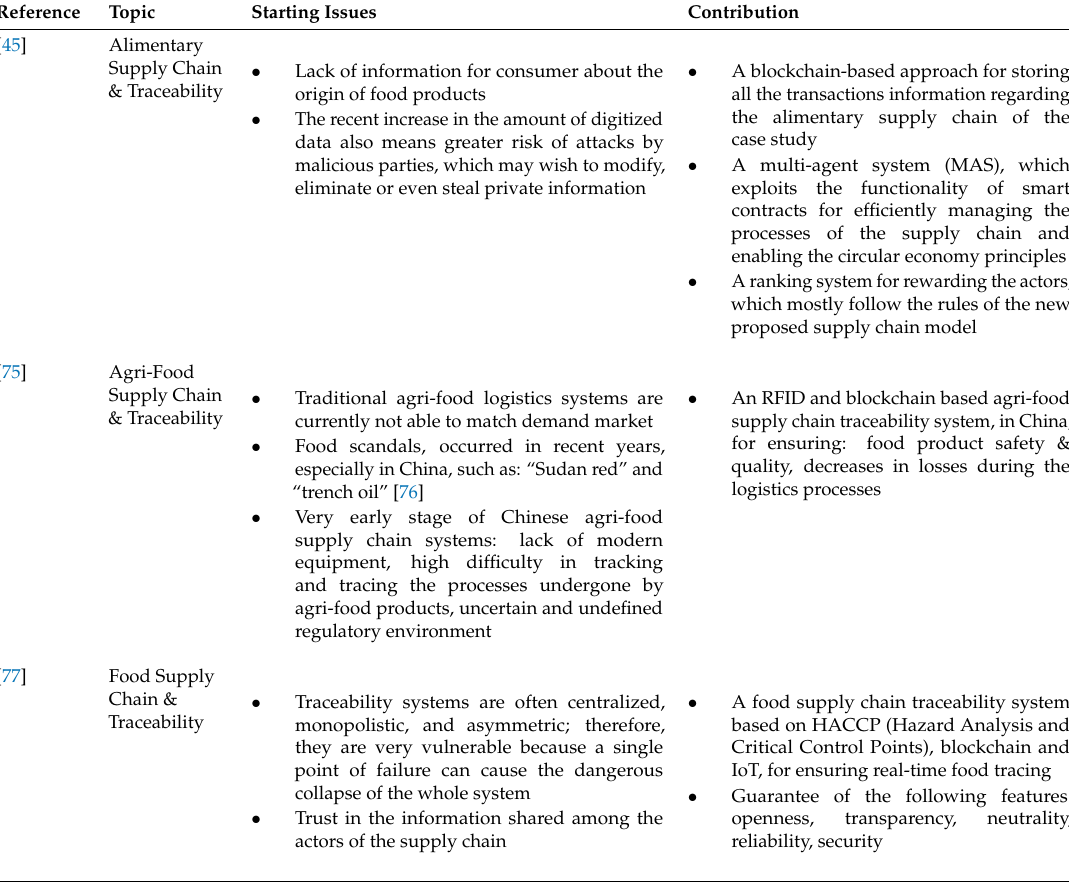
Table 5. Analysis of the most relevant documents belonging to C 1 (part